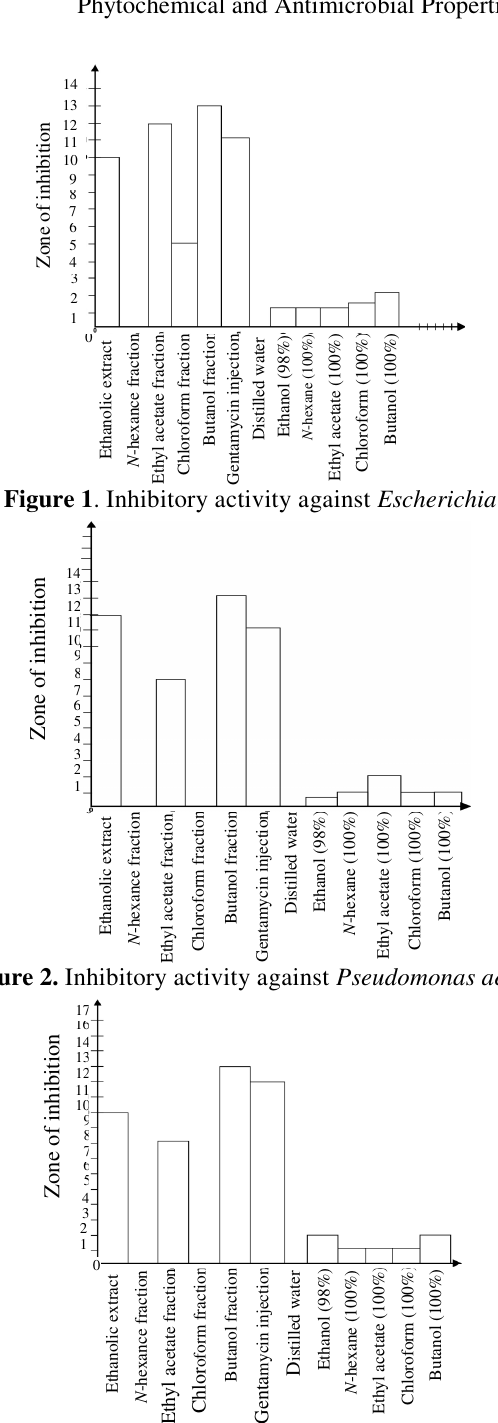
Figure 3. Inhibitory activity against Staphylococcus